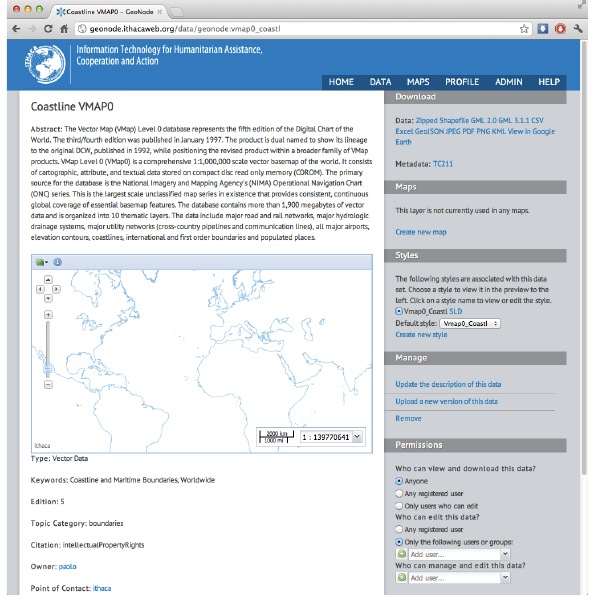
Figure 9. A dataset page in ITHACA GeoNode